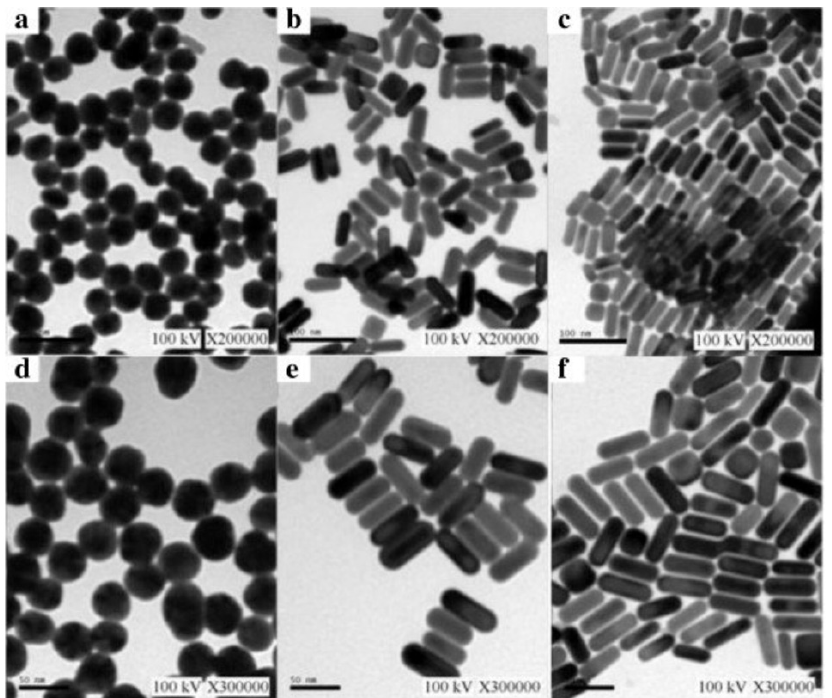
Figure 5. Various types of monodisperse AuNPs: ( a ) Au nanobones, ( b ) Au nanohoneycombs, ( c ) mesoporous silica-coated Au nanorods, ( d ) Au nanocages, ( e ) Au nanorods and ( f ) Au nanospheres. Adapted from [104].